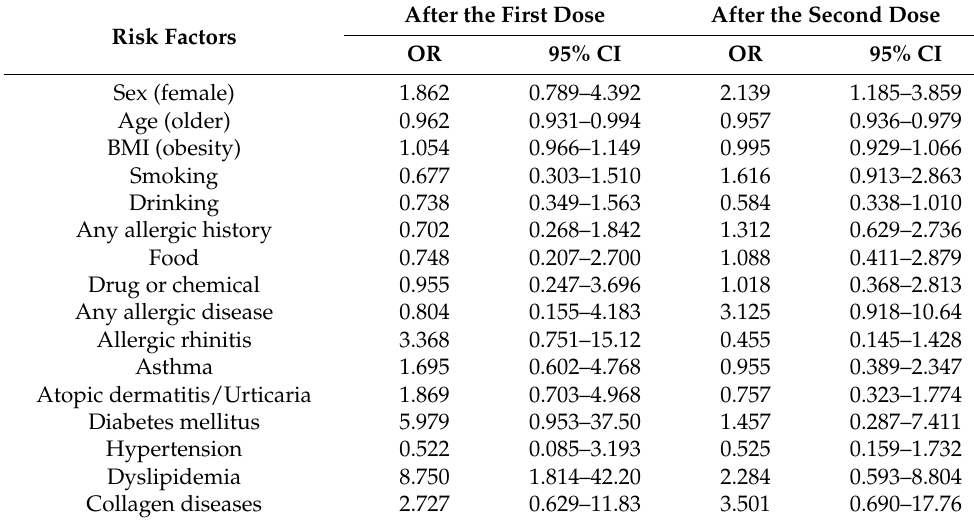
Table 2. Multivariate logistic regression analysis of risk factors associated with fever ( ≥ 37.0 ◦ C) ( n =